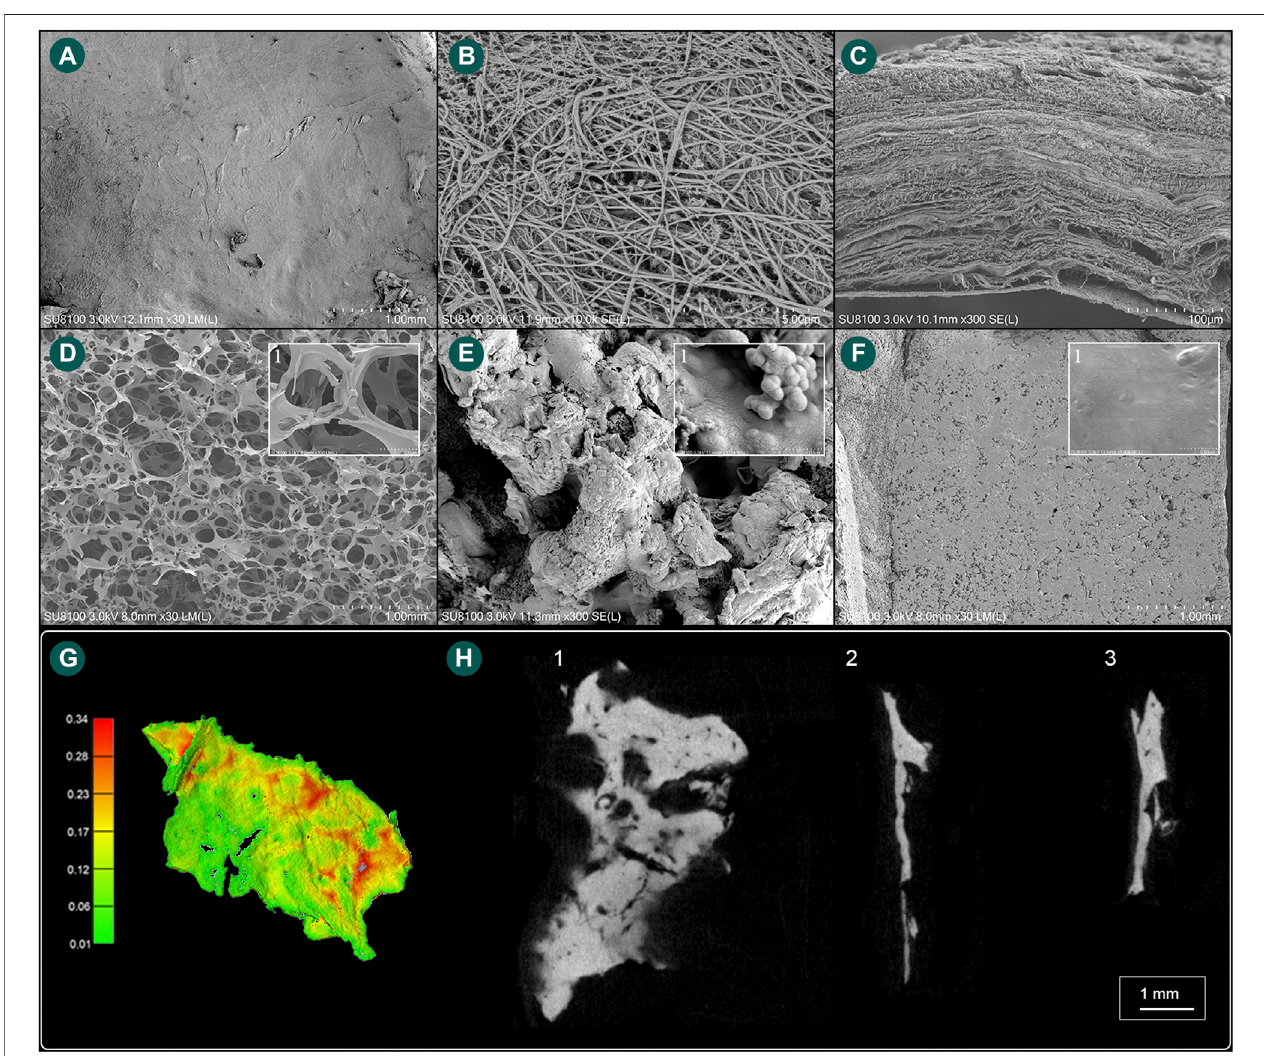
FIGURE5| Scanningelectronmicroscopeandmicrostructural characteristics oftheharvestedsigmoidplateandbiomaterialspecimens. (A) Theconcave surface of the harvested sigmoid plate (magni fi cation × 30). (B) Layers of dura mater (magni fi cation × 10,000). (C) Lateral view of the harvested transverse – sigmoid junction (magni fi cation × 300). (D) Gross view (magni fi cation × 30) of the soft gelatin sponge and (1) microscopic view (magni fi cation × 300) of pore structures of the soft gelatin sponge. (E) Gross view (magni fi cation × 300) of the solidi fi ed gelatin sponge and (1) microscopic view (magni fi cation × 30,000) of pore structures of the solidi fi ed gelatin sponge. (F) Gross view (magni fi cation × 30) of the bone wax and (1) microscopic view (magni fi cation × 6,000) of the surface of the bone wax. (G) Computed wall thicknessoftheconcavesurfaceoftheharvestedsigmoidplatespecimen. (H) (1) μ CThorizontalviewoftheharvestedsigmoidplate.(2) μ CTlateralviewoftheharvested sigmoid plate. (3) μ CT topical view of the harvested sigmoid